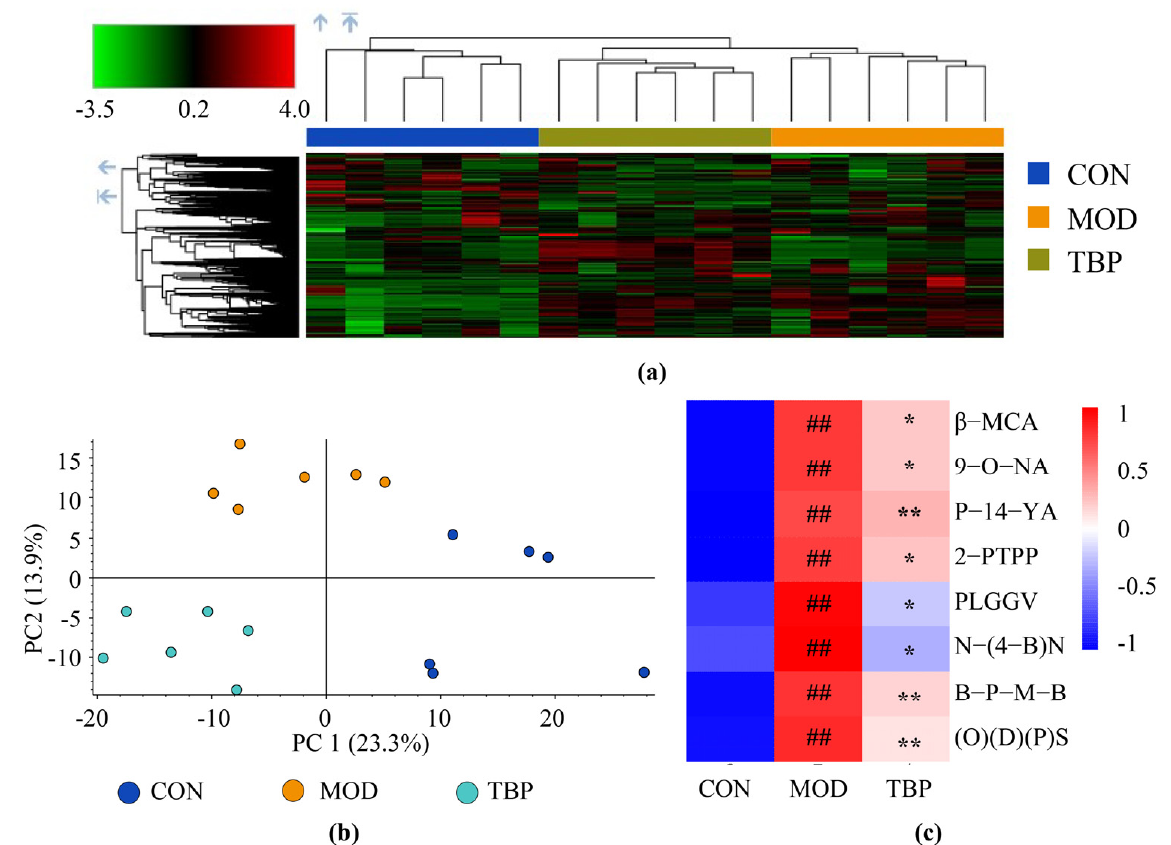
Figure 8. Effect of TBP on plasma metabolites in the HFD-fed rats. ( a ) Heat map of plasma metabolites. ( b ) PCA analysis of plasma metabolites. ( c ) Heat map of differential metabolites between groups: β -MCA, β -Muricholic